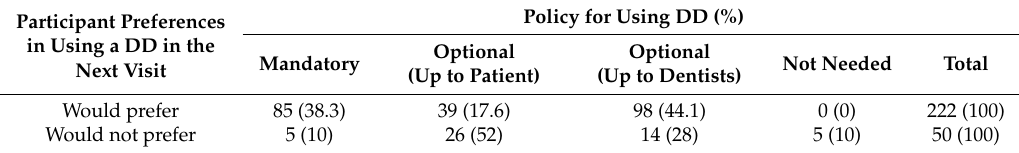
Table 6. The correlation of participant opinion on the best policy of DD use and their preference in using a DD in the next visit